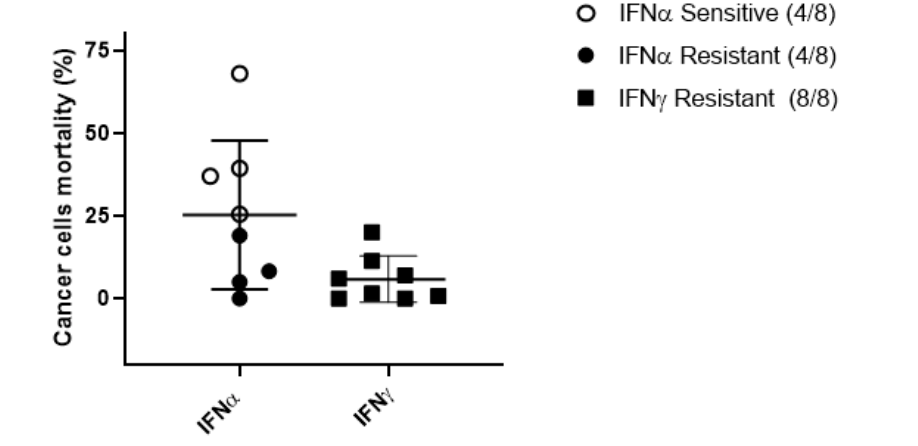
Figure 7. IFN α and IFN γ receptors (subunit 1) in wtGISTc. wtGISTc were confirmed to express IFN α / ɣ R1 even if at a lower level than monocytes, used as positive controls ( A ). The expression levels of IFN α R1 mRNA were significantly higher in wtGISTc sensitive to IFN α ( B ). All values are represented in fold change and normalized on three housekeeping genes (GAPDH, HPRT and PGK). (*** p < 0.001, nonparametric t -test). Along with the reported direct tumoricidal effect, we observed that treating wtGISTc ( n = 8) in vitro with both IFN α and IFN γ resulted in potentially relevant immunomodu- latory effects. Namely, we observed a significantly enhanced membrane expression of HLA-I/B2M molecules and immune checkpoints PD-L1 and PD-L2 (Figure 8A–D).